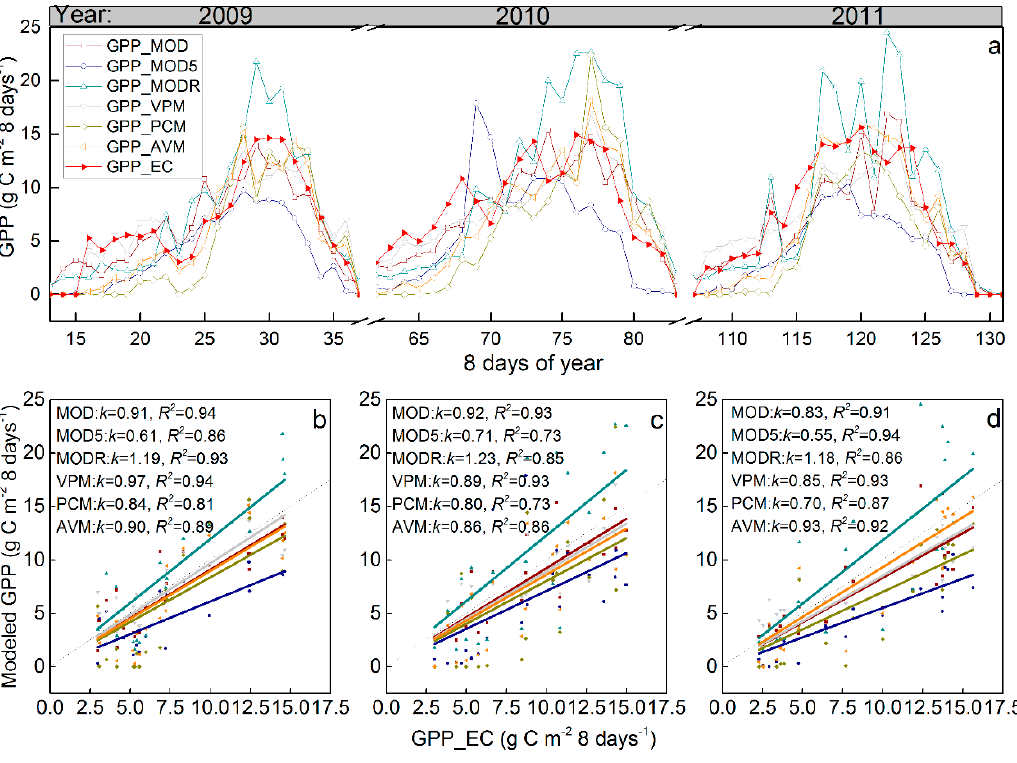
Figure 5. Seasonal variations of gross primary production (GPP) estimations from different methods ( a ); and comparison with the EC-based GPP estimations from: 2009 ( b ); 2010 ( c ); and 2011 ( d ), k values and dashed lines in ( b – d ) are the linear slope between GPP_EC and modeled GPP, and the reference lines of 1:1, respectively. All linear regressions are extremely significant ( p < 0.0001). Colors in ( b – d ) are one-to-one corresponding with different GPP estimations in ( a ), respectively. Different GPP estimations are identical to Figure 1.